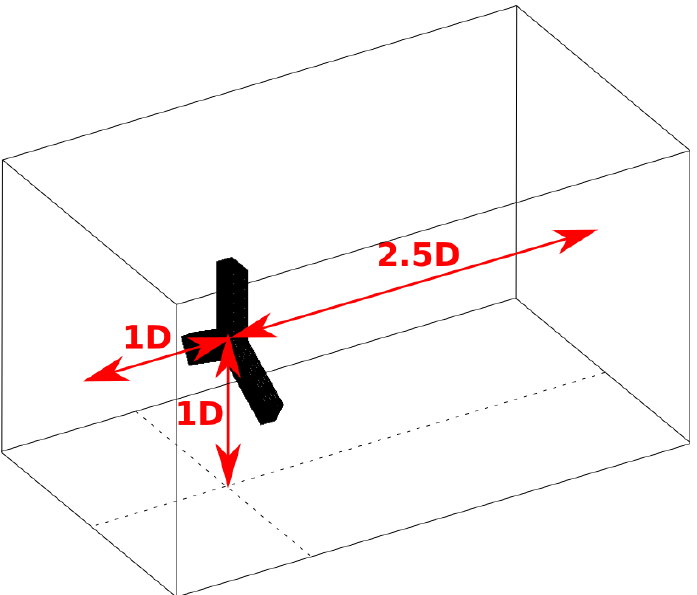
Figure 7. Visualization of the Lagrangian and the Eulerian sub-domains in the hybrid solver simula-